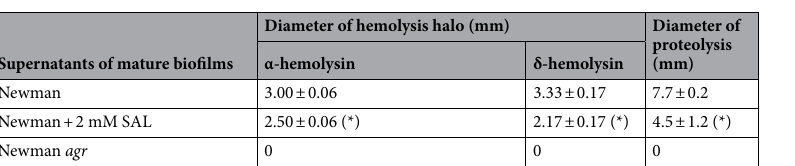
Table 2. Hemolytic and proteolytic activity of supernatants of S. aureus biofilms. Asterisks represent the significance of the decrease in the hemolysis and proteolysis abilities mediated by SAL ( t-